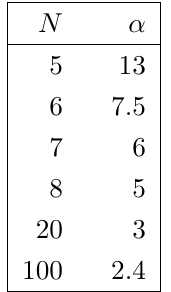
Table 1. Values for (cid:11) coe(cid:14)cient in the maximization